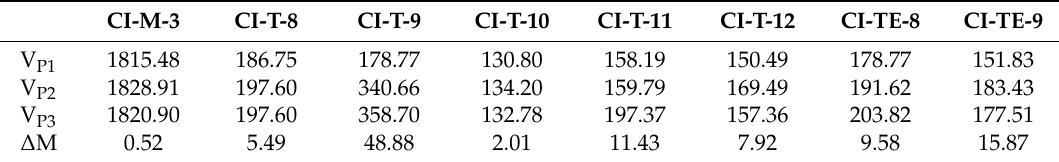
Table 5. Results of ultrasonic wave propagation through lime mortars from Irulegi Castle. V P1 , V P2 and V P3 (in m/s): P-wave velocity in three orthogonal directions; ∆ M p : total anisotropy coefficient of